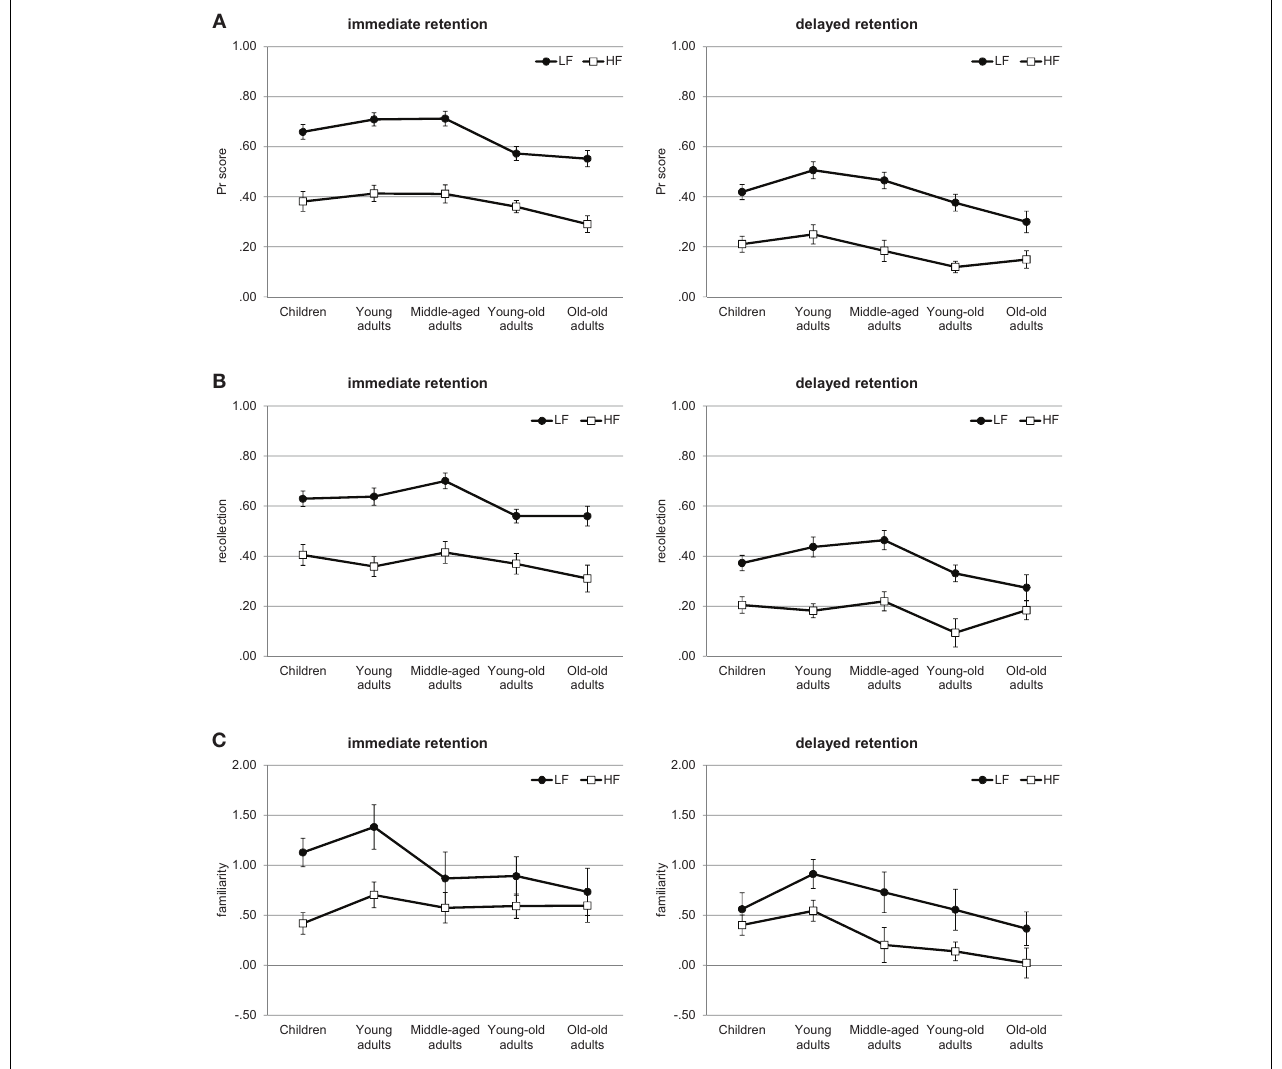
FIGURE 2 | Experiment 2. Recognition memory performance across the lifespan. (A) Pr scores. (B) Estimates of recollection. (C) Estimates of familiarity. Error bars represent standard errors. LF, low-frequency words; HF, high-frequency